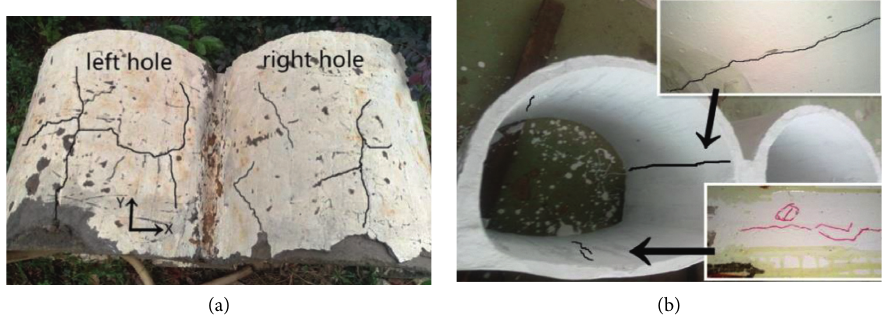
Figure 22: Cracks in the